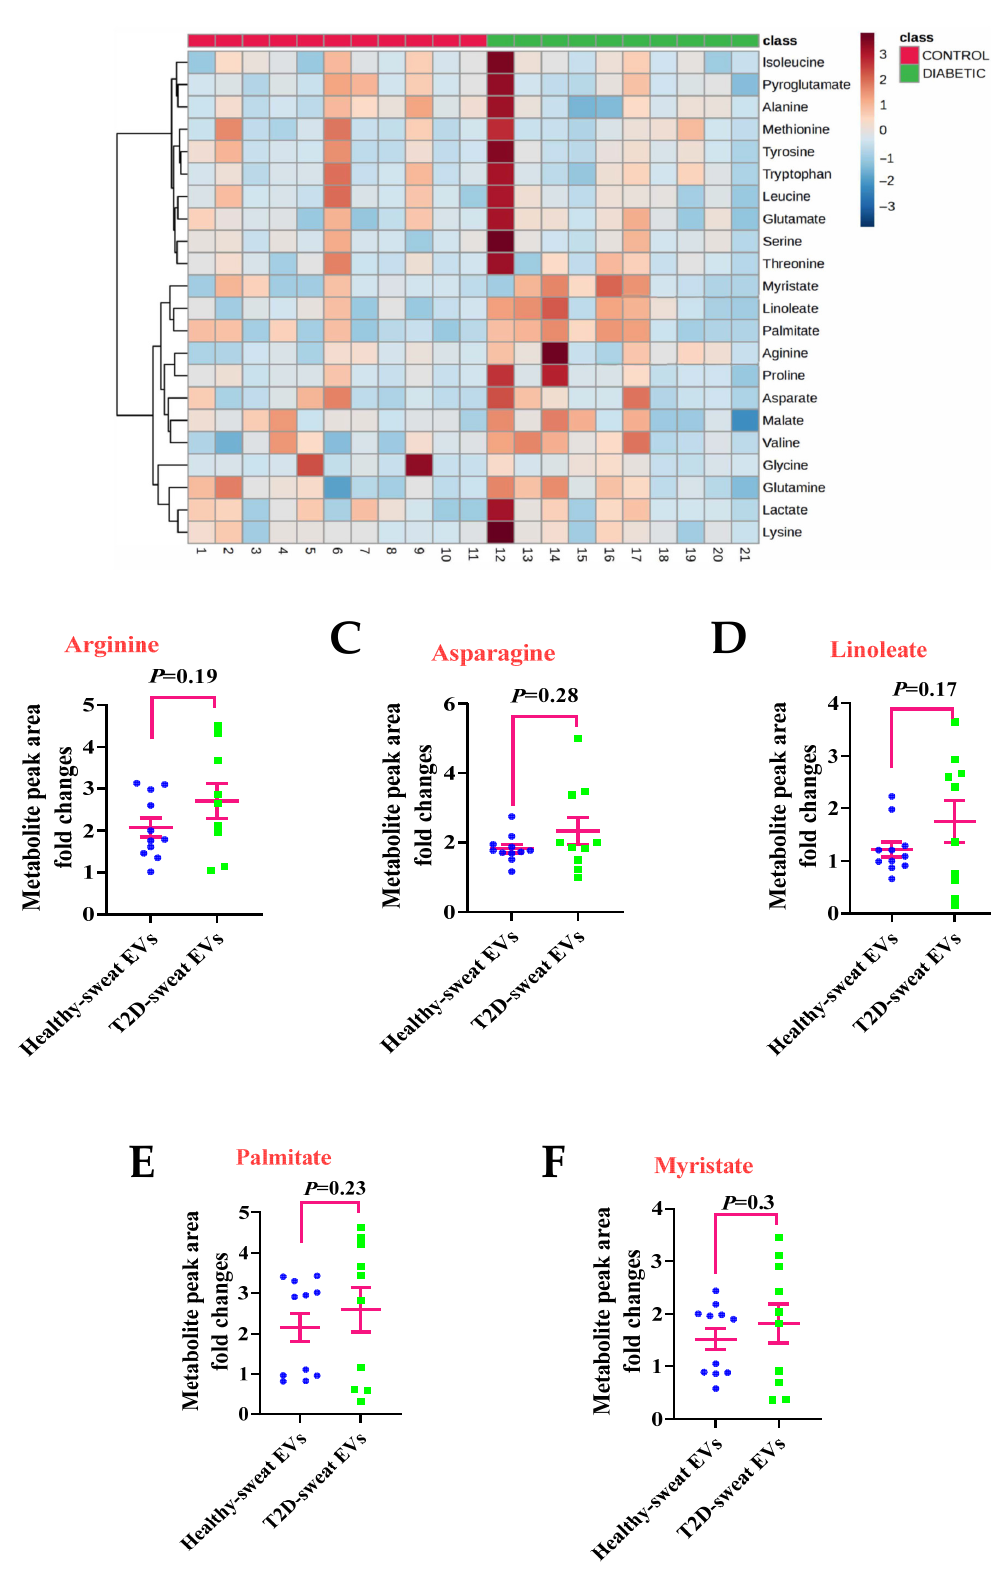
Figure 5. Metabolites from sweat EVs may reflect metabolic changes in diabetes when compared to healthy individuals. ( A ) Heatmap illustrating the metabolite pattern of healthy- and T2D-sweat EVs upon heat exposure. ( B – F ) Metabolite levels of Arginine ( B ), Asparagine ( C ), Linoleate ( D ), Palmitate ( E ), and Myristate ( F ). Data are metabolite peak area fold changes ± SEM after normalization to the total